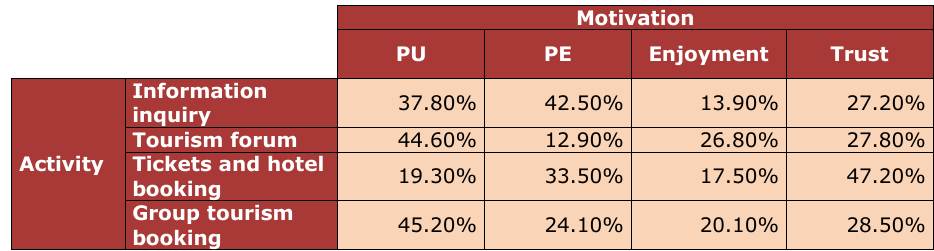
Table 2. motivations in tourism e-commerce